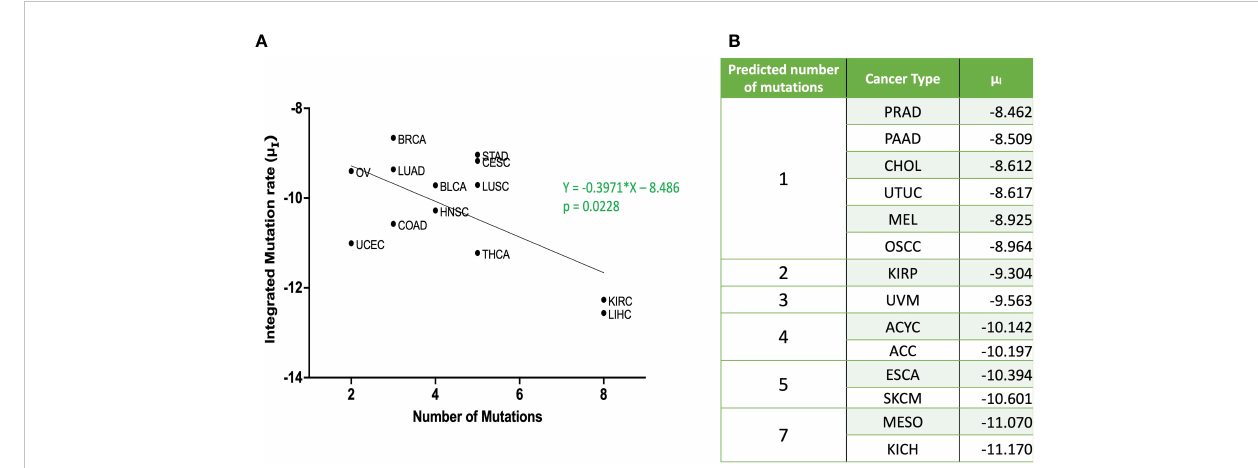
FIGURE 7 Relationship between integrated mutation rate and number of mutation hits required for cancer initiation (A) Published data for number of mutational hits required for carcinogenesis (37) in some cancer types was plotted against corresponding integrated mutation rate ( m 1 ∙ m S − 1 ∙ m S ). The linear regression was performed, and the regression line and the p value are shown. (B) Predicted number of mutations for unpublished cancer types as per equation from (A) ACC, Adrenocortical Carcinoma; BLCA, Bladder Urothelial Carcinoma; BRCA, Breast Invasive Carcinoma; CESC, Cervical Squamous Cell Carcinoma; CHOL – Cholangiocarcinoma; COAD, Colorectal Adenocarcinoma; ESCA, Esophageal Adenocarcinoma; HNSC, Head & Neck Squamous Cell Carcinoma; KICH, Kidney Chromophobe; KIRC, Kidney Renal Clear Cell Carcinoma; KIRP, Kidney Renal Papillary